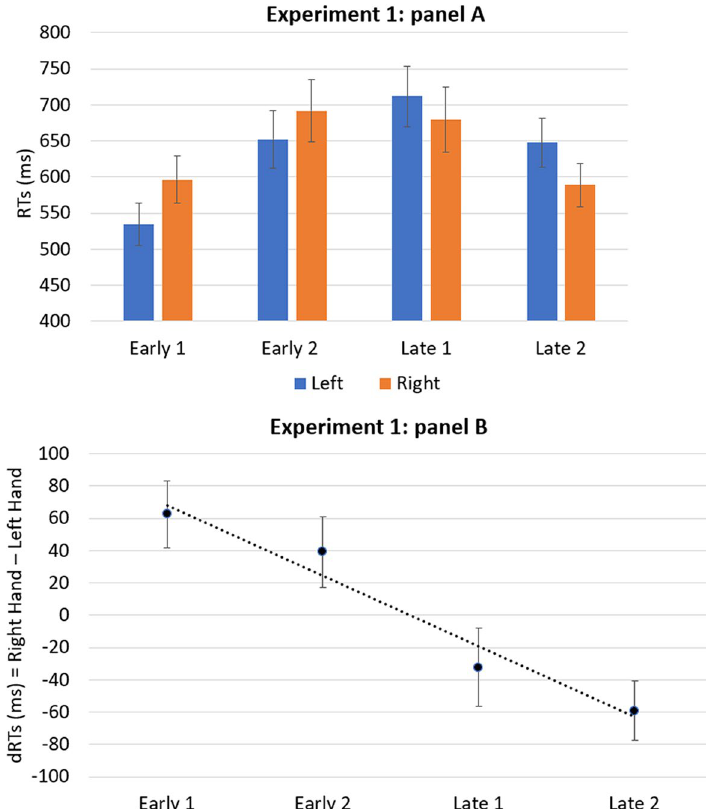
Figure 1. The panel ( A ) shows the mean of response times of the left and right hands, for the four onset timing of the target (early 1, early 2, late 1, late 2). The panel ( B ) shows the mean dRTs (right key–left key) for the four onset timing of the target. Positive differences indicate faster left-key responses; negative differences indicate faster right-key responses. Errors bars indicate standard error of the